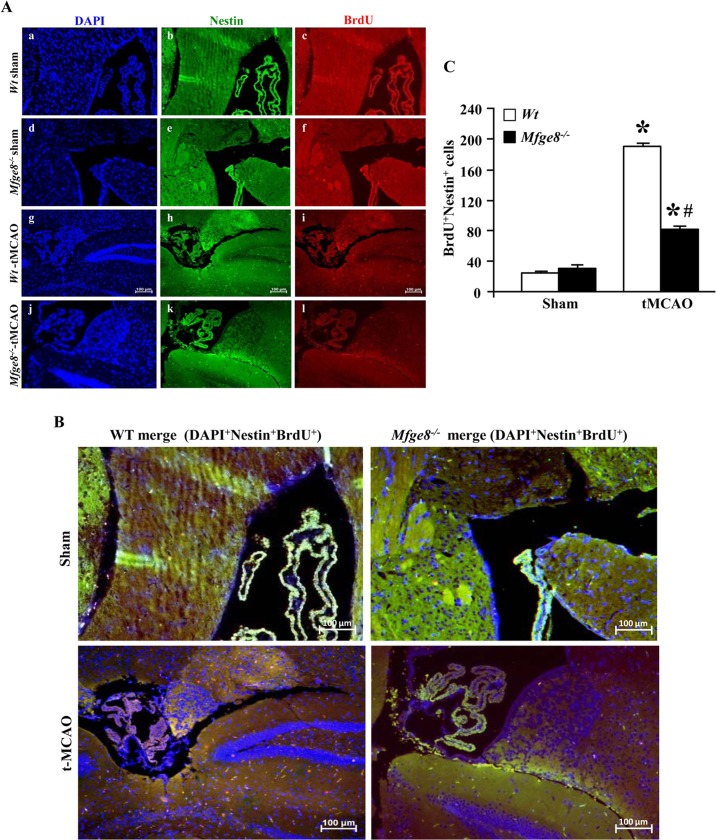

Mfge8
-/- mice represent decreased neural stem cell proliferation after cerebral ischemia.(A) DAPI, Nestin and BrdU immunofluorescent staining of the subventricular zone in mice. Wild type C57BL/6 (Wt) (a-c) and Mfge8
-/- mice (d-f) showed similar sham baseline neural stem cell proliferation (Nestin+ and BrdU+ cells). Wt mice (g-i) showed increased Nestin+ and BrdU+ staining compared with the Mfge8
-/- mice (j-l) at 7 days after tMCAO. Scale bar = 100 μm. (B) Representative merged profiling of DAPI, Nestin and BrdU positive cells showing considerable increase in Nestin+BrdU+ cells in Wt tMCAO mice than that of Mfge8
-/- tMCAO mice. (C) Quantification of the BrdU+Nestin+ cells showed that Wt and Mfge8
-/- sham mice had similar baseline numbers of proliferating neural stem cells. However, at 7 days post-tMCAO, Wt mice showed a 2.3-fold increase in BrdU+Nestin+ cells compared with Mfge8
-/- mice. Data are presented as mean ± SEM. *p<0.05 vs WT-Sham; #p<0.05 vs WT-tMCAO; n = 3/group.